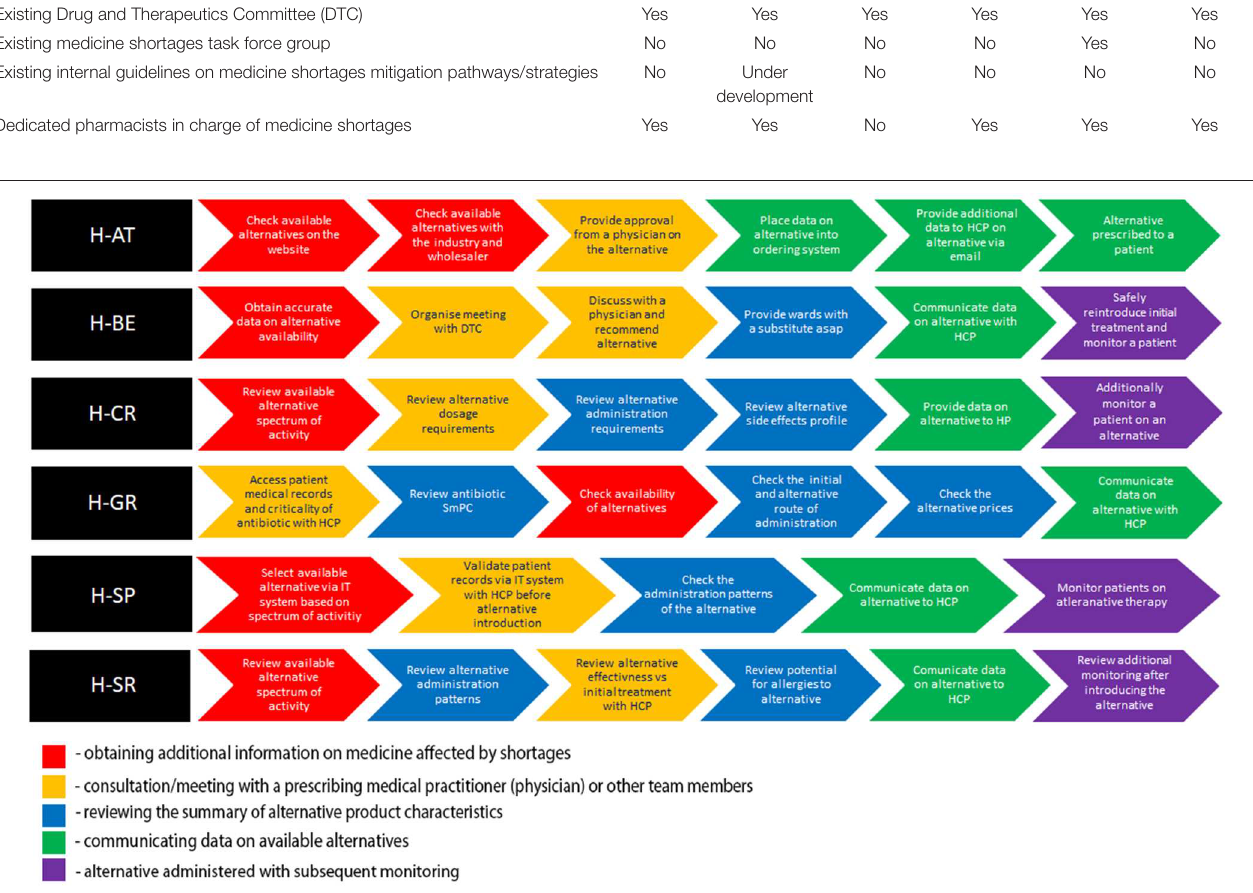
FIGURE 1 | Color-coded flowchart highlighting similar patterns in sub-processes across health-care failure mode and effect analysis (HFMEA) study